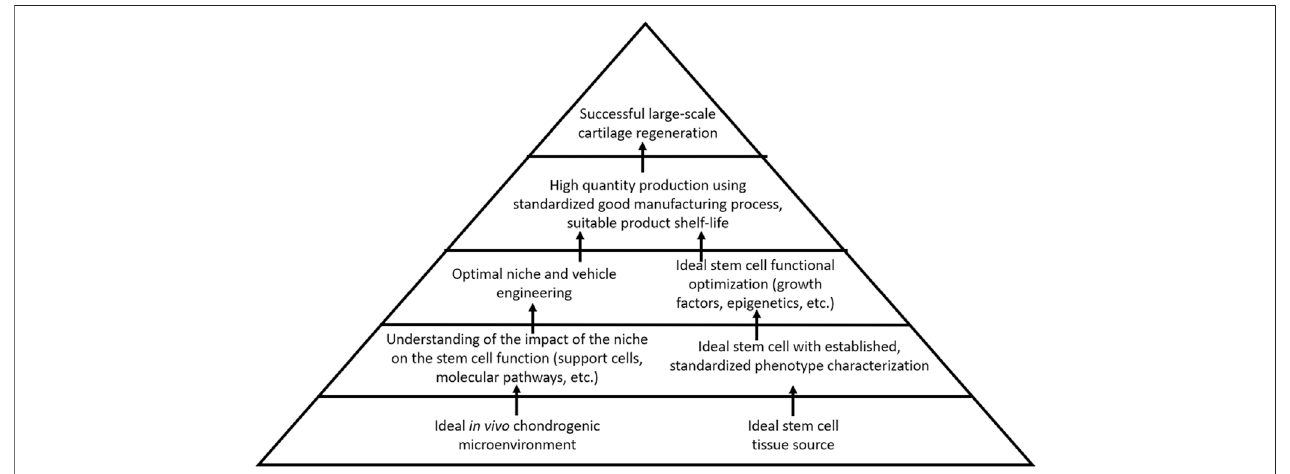
FIGURE 2 | Suggested directions for cell-based therapy research for cartilage